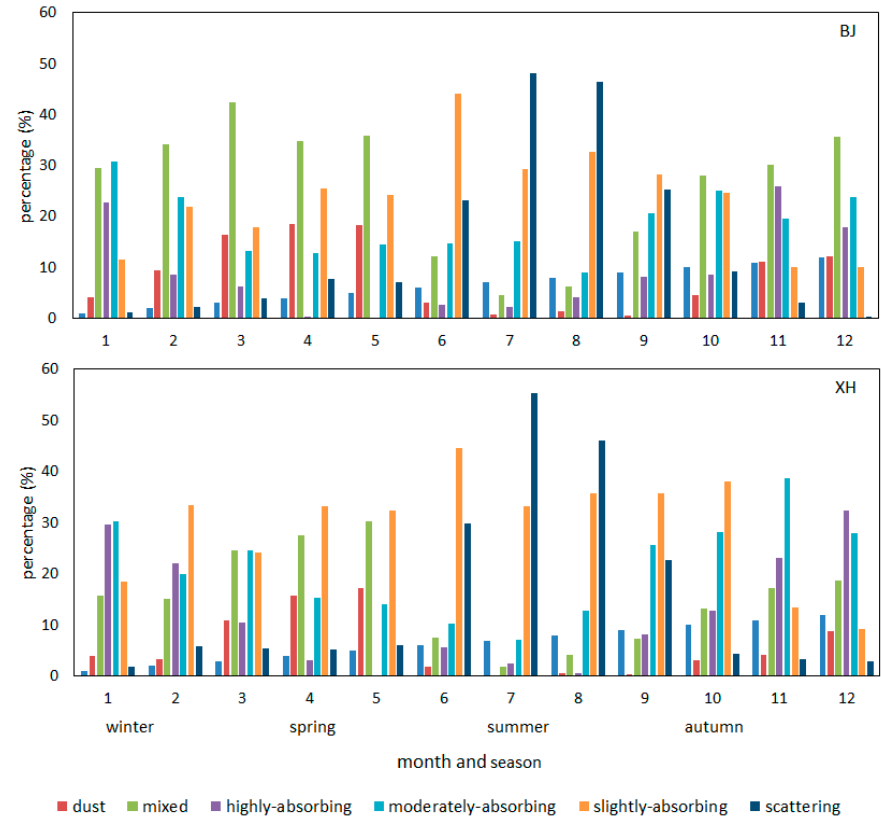
Figure 6. Monthly and seasonal percentage of aerosol types at different stations in BJ and XH (N = 2336 and N = 2554, respectively).